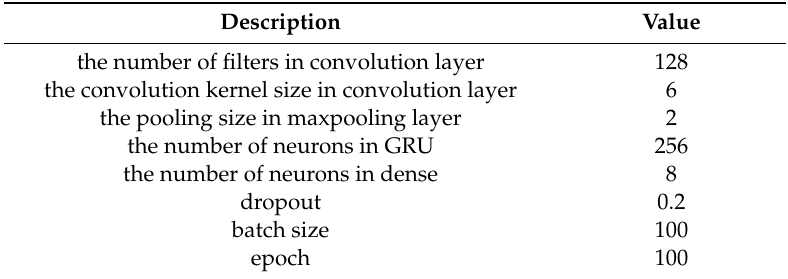
Table 5. The parameters used in fault diagnosis.